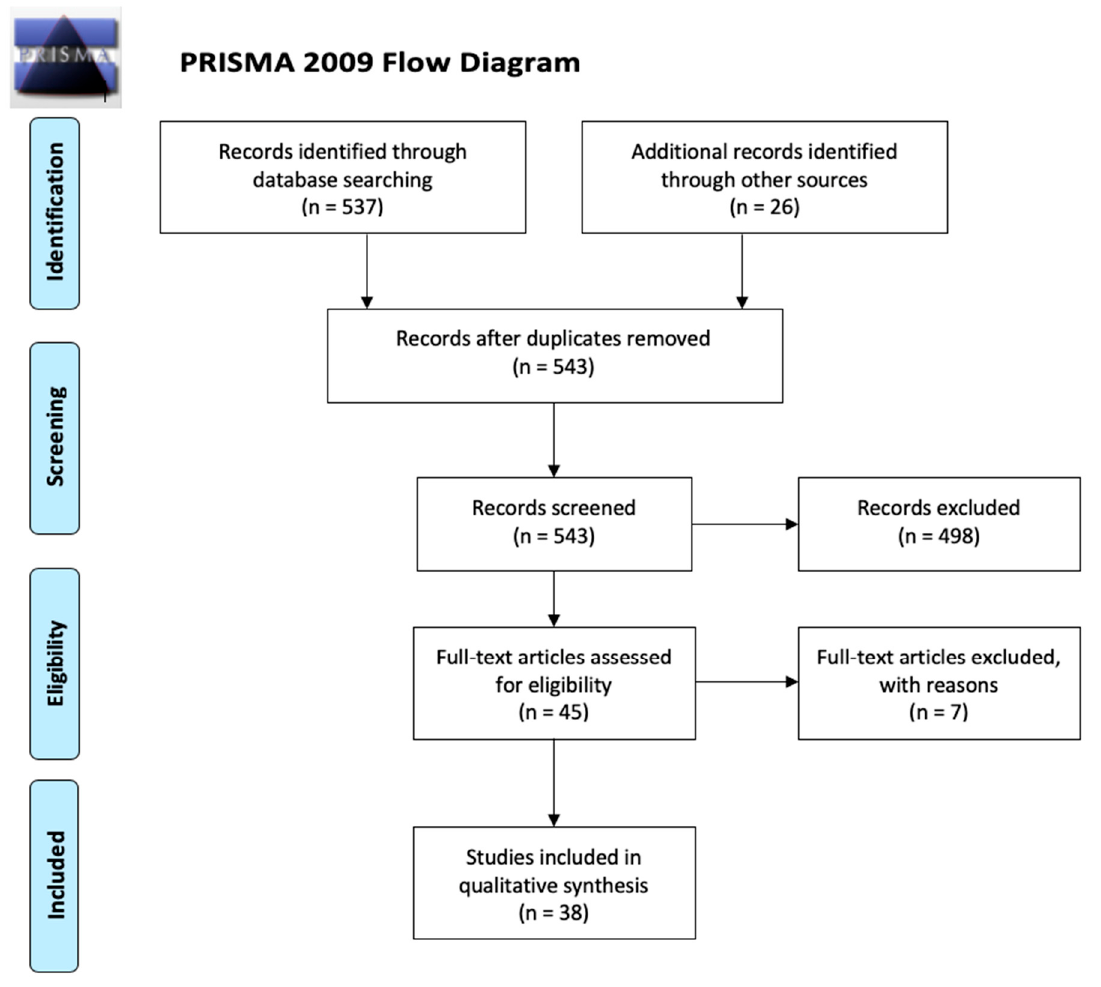
Figure 1. Overview of selection of relevant records according to the PRISMA guidelines (2009).